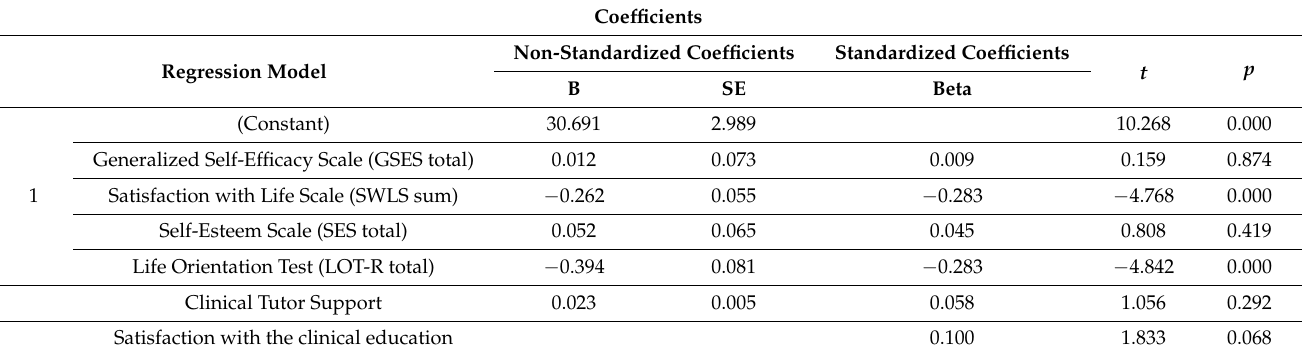
Table 5. The results of the regression analysis between the intensity of perceived stress and selected psychosocial